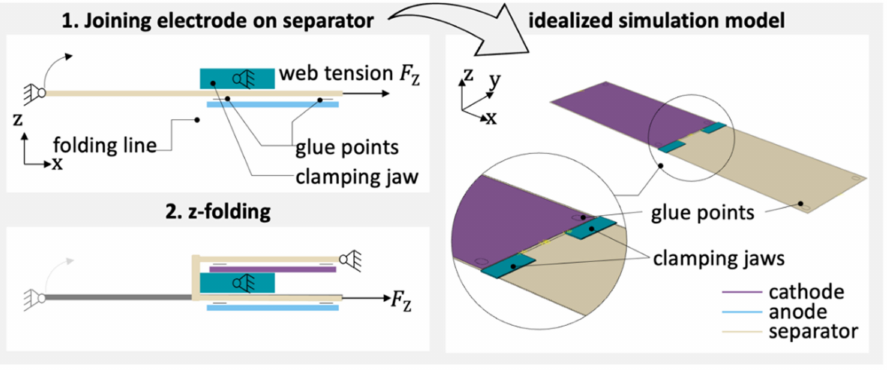
Figure 18. Idealization of z-folding process for simulation ( left ) and simulation model ( right ) [8]. To simulate the folding motion, the left edge of the separator is rotated around the y-axis, while the acting web tension force at the right edge is kept constant. Since the bending deformation of the separator at the fold line considered here does not represent a static load case and is time-dependent, a dynamic–explicit simulation step is performed. The total duration of the folding movement corresponds to the format-dependent duration of the z-folding process and is taken from analytical